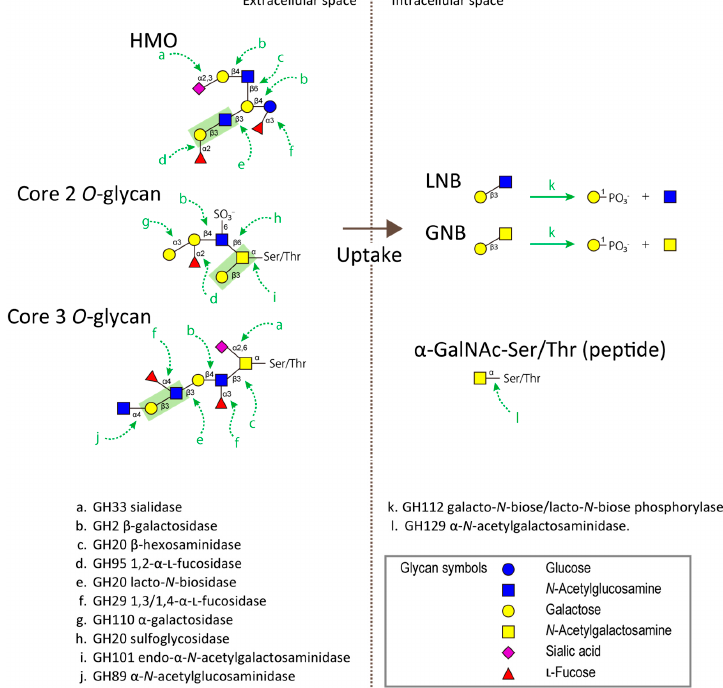
Figure 1. Enzymes involved in the degradation and assimilation of human milk oligosaccharides (HMOs) and mucin O -glycans by B. bifidum . The sugars are depicted according to the nomenclature committee of the Consortium for Functional Glycomics (http://www.functionalglycomics.org/static/index.shtml).